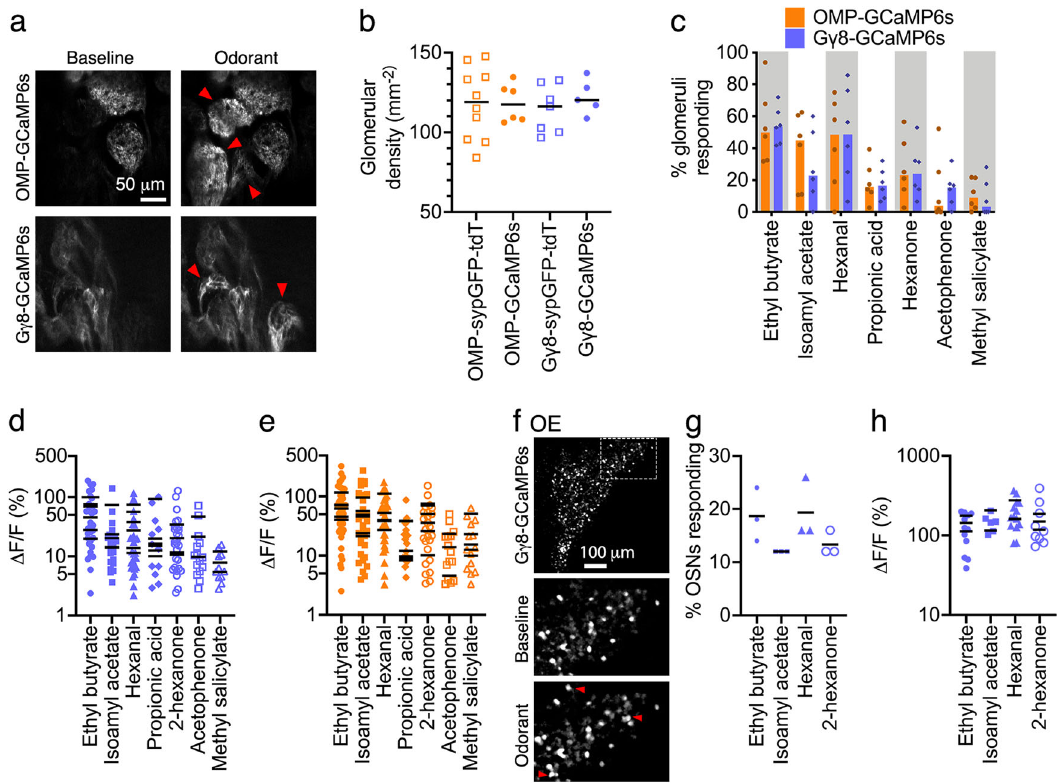
Fig. 2 | Immature OSNs respond to odorants. a Example single z-plane 2-photon tested odorants in OMP-GCaMP6s mice (Nested one-way ANOVA. P =0.073, n =6 mice). d , e Lines: mean per mouse, symbols: individual glomeruli. F images during single trial showing baseline fl uorescence and odorant-evoked 6,31 =2.17. Notallmicehadglomerulithatrespondedto allodorants. f Examplesinglez-plane responses in OMP-GCaMP6s and G γ 8-GCaMP6s mice. Red arrows: ethyl butyrate- 2-photon images showing immature OSNs in the OE responding to ethyl butyrate responsive glomeruli. b No effect of OSN maturity or reporter protein(s) on the stimulation exvivo. Top: imaged fi eldof view showing medial OEsurface of a G γ 8- density of detected glomeruli (Two-way ANOVA. Effect of OSN maturity: P =0.99, − 5 . Effect of reporter protein(s): P =0.55, F F GCaMP6s mouse in the hemi-head preparation. Lower: baseline and odorant- 1,24 =2.93×10 1,24 =0.37. Interaction: n =10 OMP-sypGFP-tdT, 6 OMP-GCaMP6s, 7G γ 8-sypGFP-tdT P =0.57, F evoked fl uorescence in boxed region in top image. Red arrows: ethyl butyrate- 1,24 =0.33. and 5G γ 8-GCaMP6s mice). Lines: mean, symbols: individual mice. c A similar per- responsive immature OSNs. g Similar percentage of immature OSNs responded to centage of glomeruli respond to each of the 7 odorants in OMP-GCaMP6s vs. G γ 8- each odorant (Friedman test. P =0.15, Friedman statistic=5.44, n =3 mice). Lines: GCaMP6smice(Wilcoxonsignedranktest. P =0.47, W = − 10, n =6micepergroup). mean,symbols:individualmice. h ImmatureOSNresponseamplitudesweresimilar Colored bars: median, symbols: individual mice. Gray shaded areas are to aid acrossodorants(Nestedone-wayANOVA. P =0.53, F 3,91 =0.75, n =6 – 13responding OSNs per mouse for each odorant). Lines: mean per mouse, symbols: individual visualization only. d No signi fi cant difference in response amplitude between tes- OSNs. All relevant statistical tests were two-tailed. Source data are provided as a ted odorants in G γ 8-GCaMP6s mice (Nested one-way ANOVA. P =0.080, n =6 mice). e No signi fi cant difference in response amplitude between F Source Data fi 6,30 =2.12,